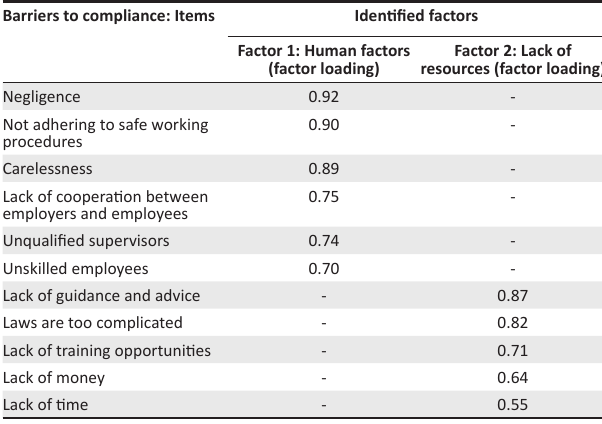
TABLE 5: Exploratory factor analysis on barriers to occupational health and safety compliance. Barriers to compliance: